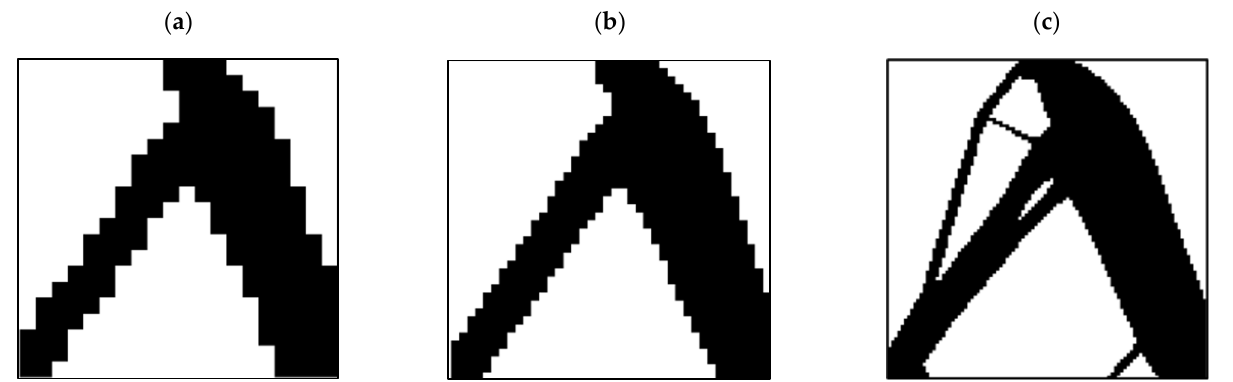
Figure 4. The effect of element size on the optimization response: ( a ) 50, ( b ) 25, and ( c ) 10 (mm).